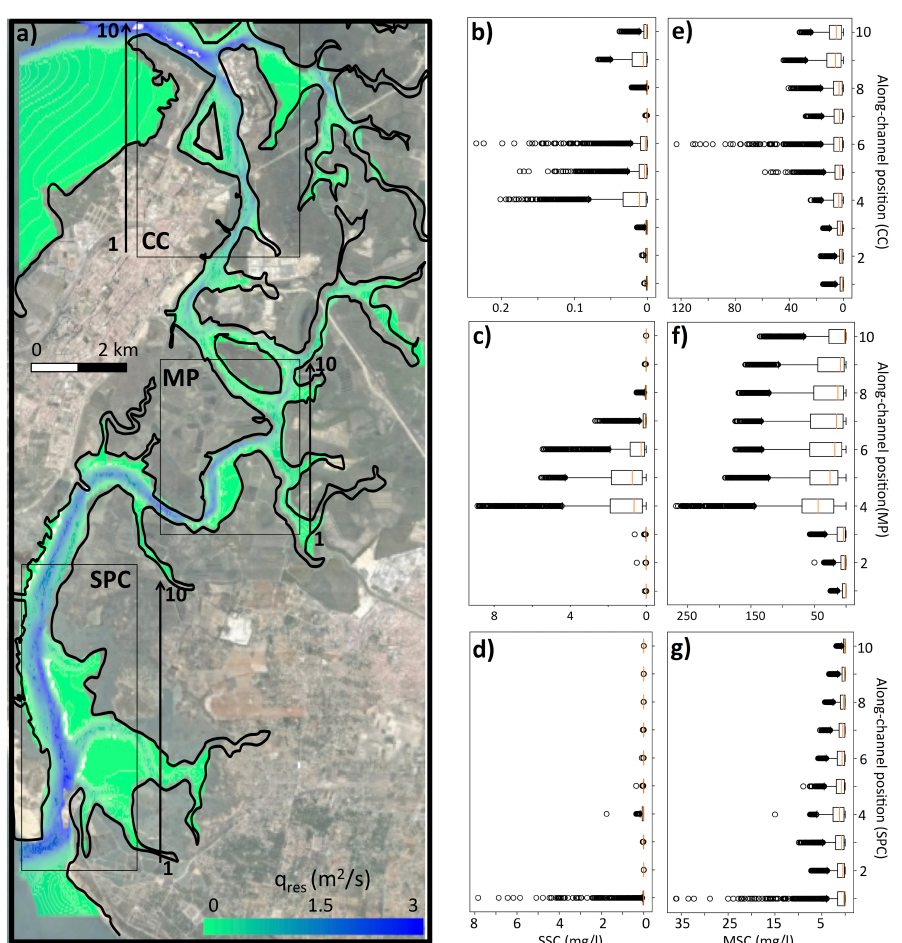
Figure 10. ( a ) Color coded representation of the residual flow magnitudes (m 2 /s) at maximum flood period. The sand suspended concentration (mg/L; panels ( b – d )) and the mud suspended concentration (mg/L; panels ( e – g )) are shown for 3 cross-sections (North, central and south, defined in panel ( a ). Vertical axes on panels ( b – g ) refer to the along-channel position of 10 points equally distributed along the areas highlighted in panel ( a